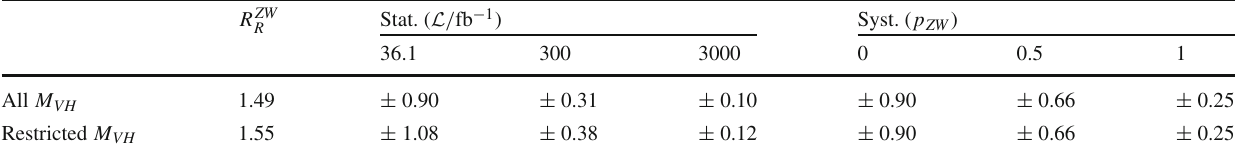
Table 1 Numerical results for the double ratio R ZW vidual systematic uncertainties of ZH and WH to be fully uncorre- and the asso- R lated, moderately-correlated, and fully correlated, respectively ( p ZW = ciated statistical and systematic uncertainties, obtained by mimick- ( 0 , 0 . 5 , 1 . 0 ) ). In the second line, the VH invariant mass was restricted ing the analysis of Ref.[40]. The statistical uncertainty is evaluated for three values of the integrated luminosity ( L = 36 . 1, 300, and to M VH ∈ ( 350 , 650 ) GeV. The systematic uncertainties are 3000fb − 1 ). The systematic uncertainty is shown by assuming the indi-